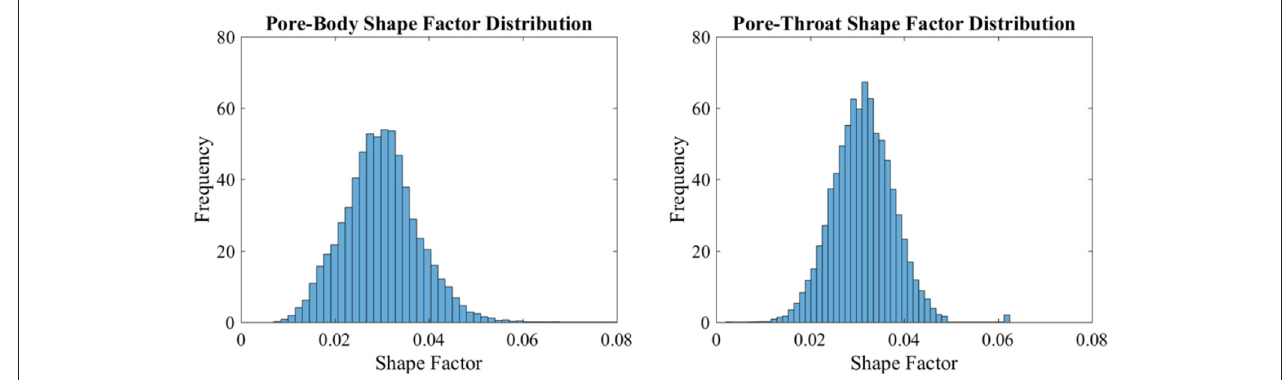
FIGURE 7 | Shape factor distribution of pore elements in the extracted pore-network of Berea sandstone sample: (left) pore-body shape factor distribution, (right) pore-throat shape factor distribution.